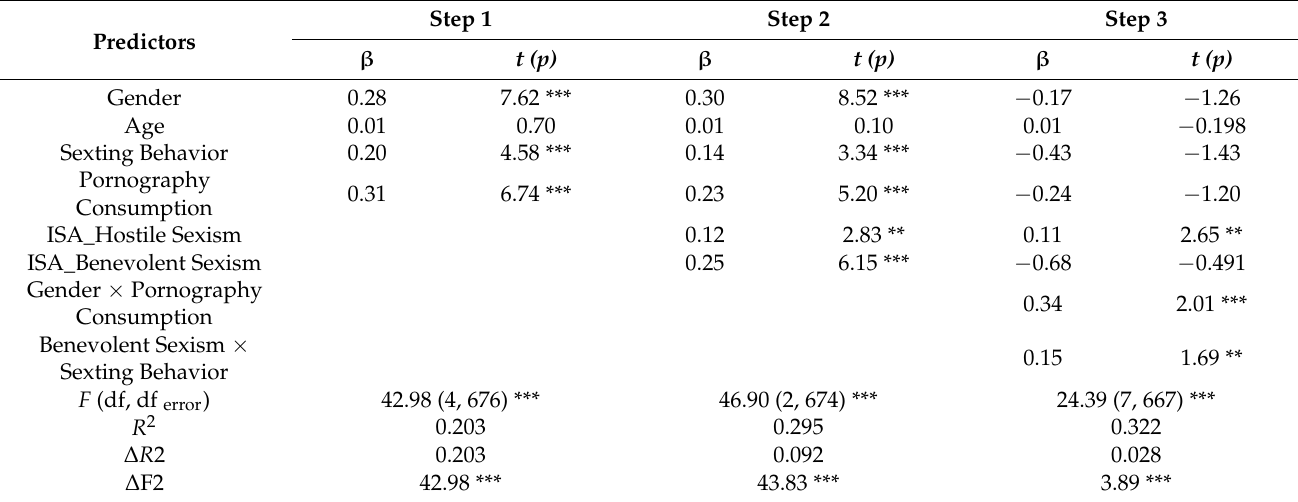
Table 3. Hierarchical linear regression analysis predicting intimate partner cyberstalking.